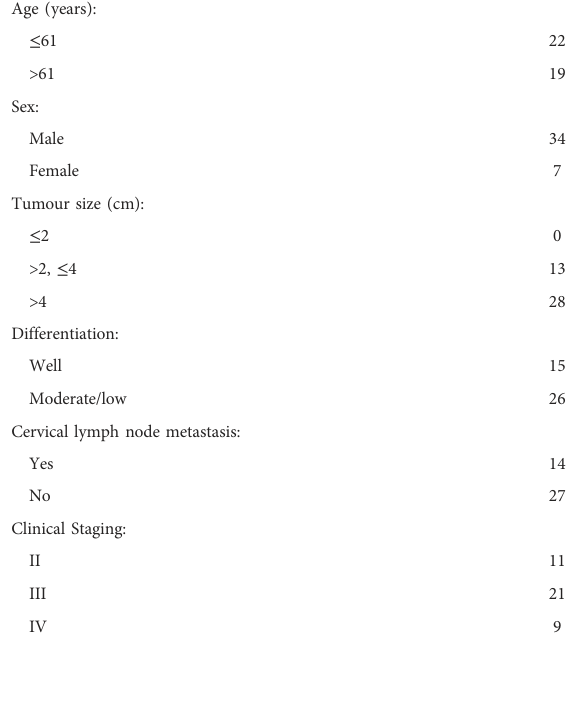
TABLE 1 Characteristics of the